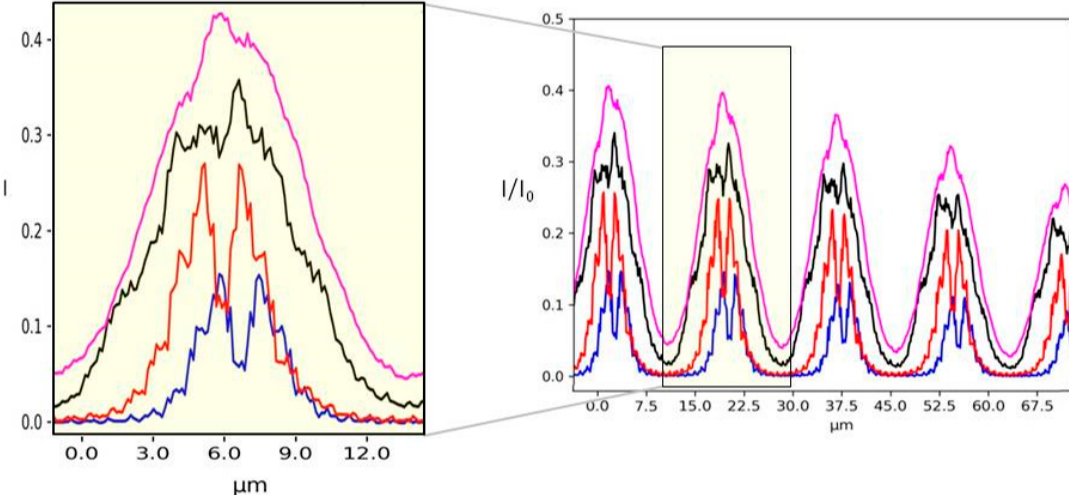
Figure 8. Single line plot of the 2D images shown in Figure 7 varying N . N = 1 (blue line), N = 10 (red line), N = 100 (black line) and N = 1000 (purple